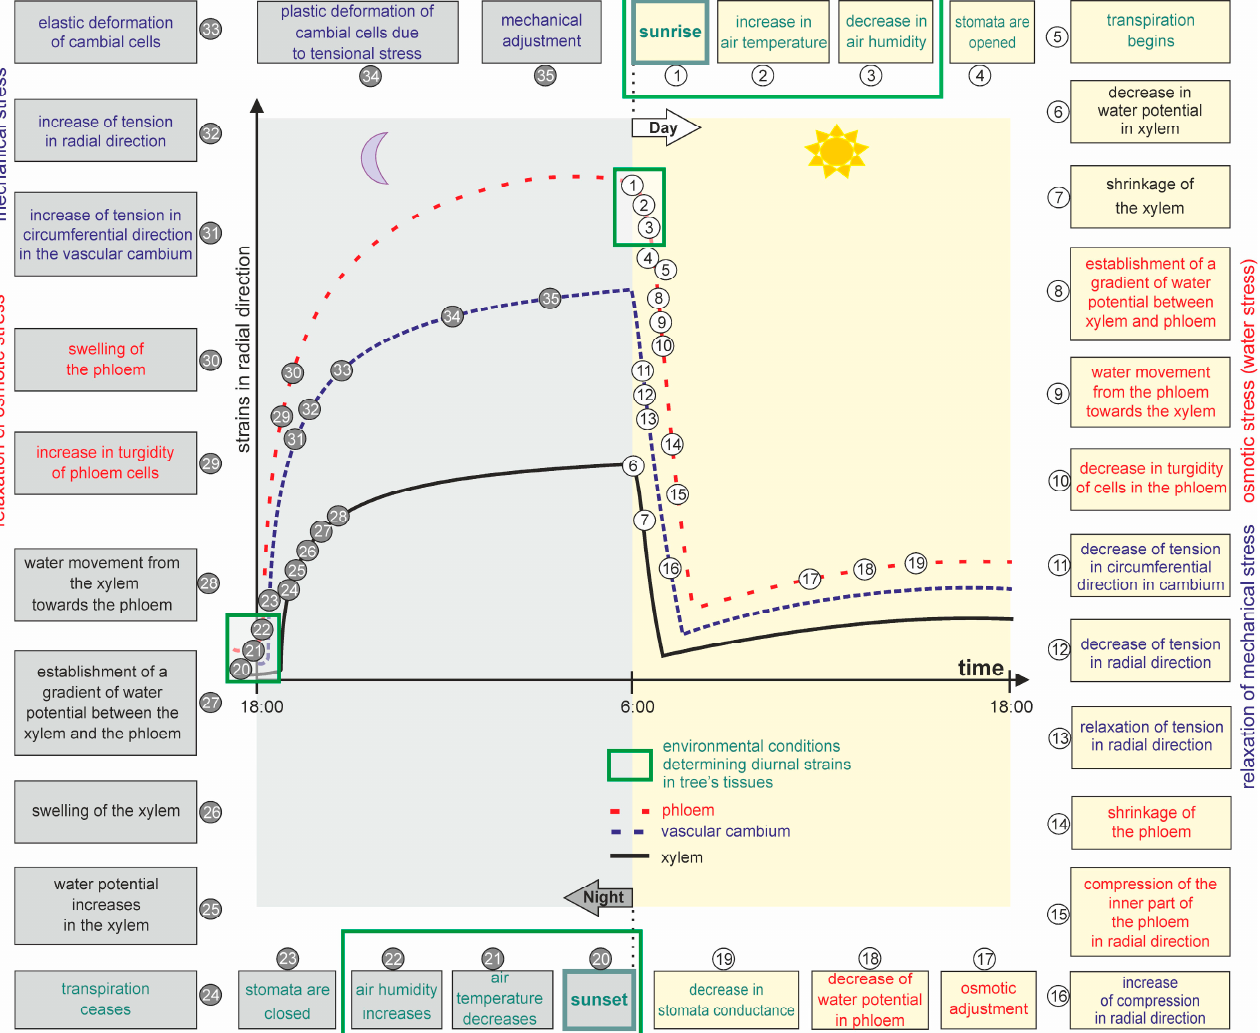
Figure 6. Osmo-mechanical hypothesis of radial growth of broadleaved trees. A single module (numbers 1–35) represents the mechanism of diurnal stress fluctuations in the tree trunk. Numbers 1 to 19 represent daytime processes and events, and numbers 20 to 35 describe nighttime processes and events. The description of the radial growth of trees under equinox conditions serves to simplify the message and thus, in the basic version of the hypothesis, allows us to abstract from the effects of day and night length changes during the growing season on a developmental process. For the sake of simplicity, it is also assumed that in the vascular cambium there are only longitudinal anticlinal divisions and equal periclinal divisions and that the growth is symplastic. See text for detailed description (the scheme is an original development of the idea presented by Kojs and Rusin 2011 [134]).